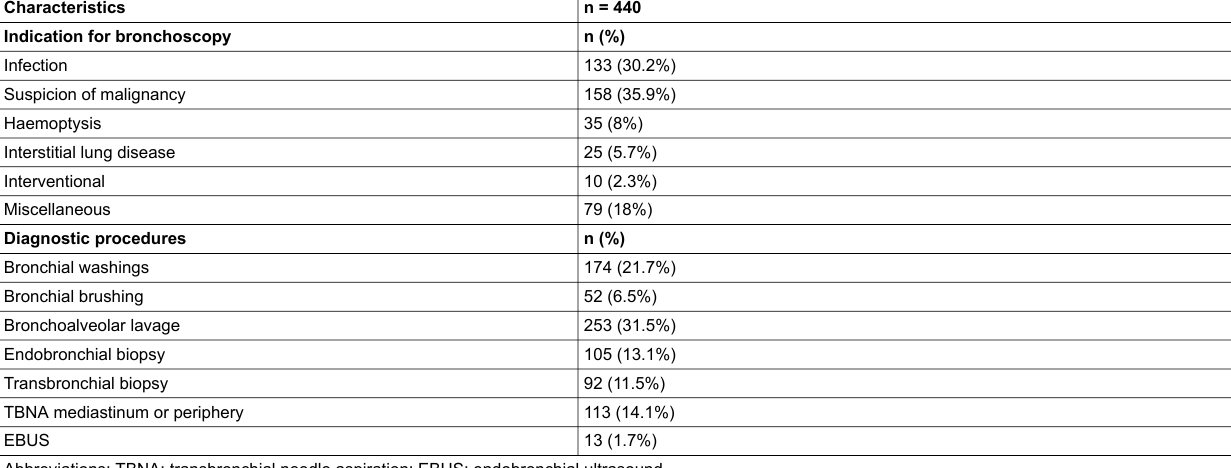
Table 3: Indications for flexible bronchoscopy and bronchoscopic procedures performed. Characteristics